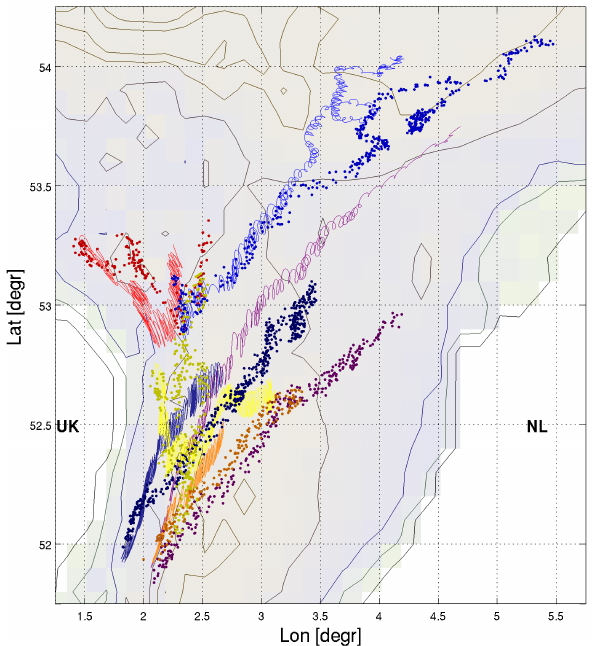
Figure 3. Comparison between six drifter paths (different coloured dots) and modelled trajectories (shown in differently coloured lines). The starting-point of each of the drifter-buoy pairs is shown as a thicker circle, and is generally located close to the UK